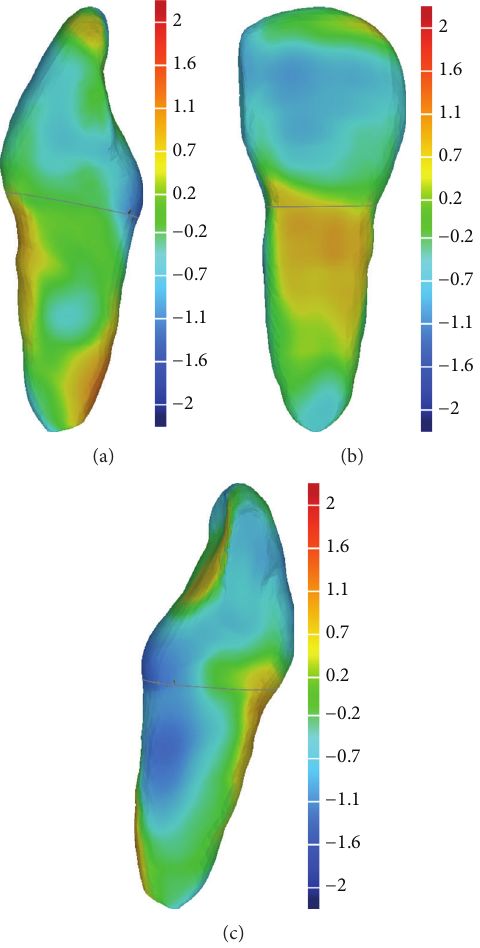
Figure 7: Superimposition and dimensional comparison between the dimensional parametric model and the segmented model of the upper incisor from a mesial view (a), from a buccal view (b), and from a distal view